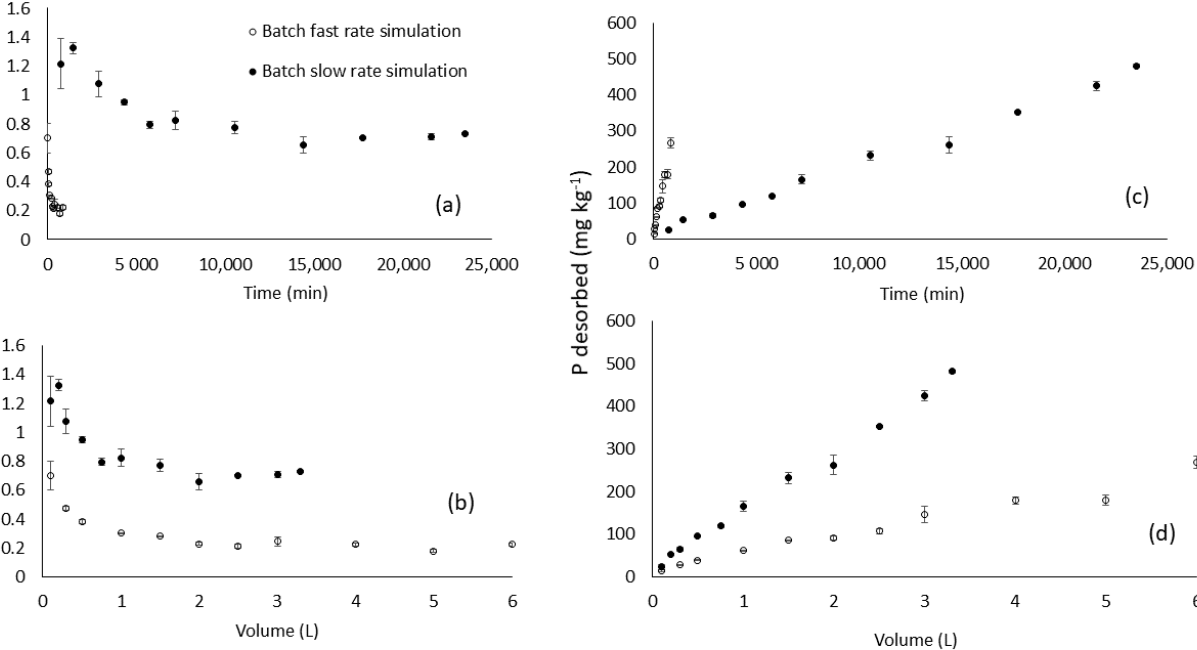
Figure 4. Batch simulated flow-through phosphorus (P) desorption test (variable volume and variable time). Solution P concentrations shown as a function of time ( a ) and volume ( b ) corresponding to the flow-through cumulative time and volume for fast and slow flow rates. Phosphorus desorption additionally expressed per unit soil mass as a function of time ( c ) and volume ( d ). Error bars = standard deviation.